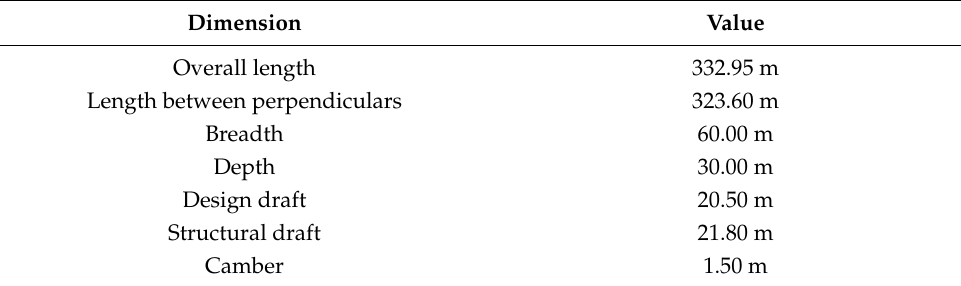
Table 3. Principal dimensions of target